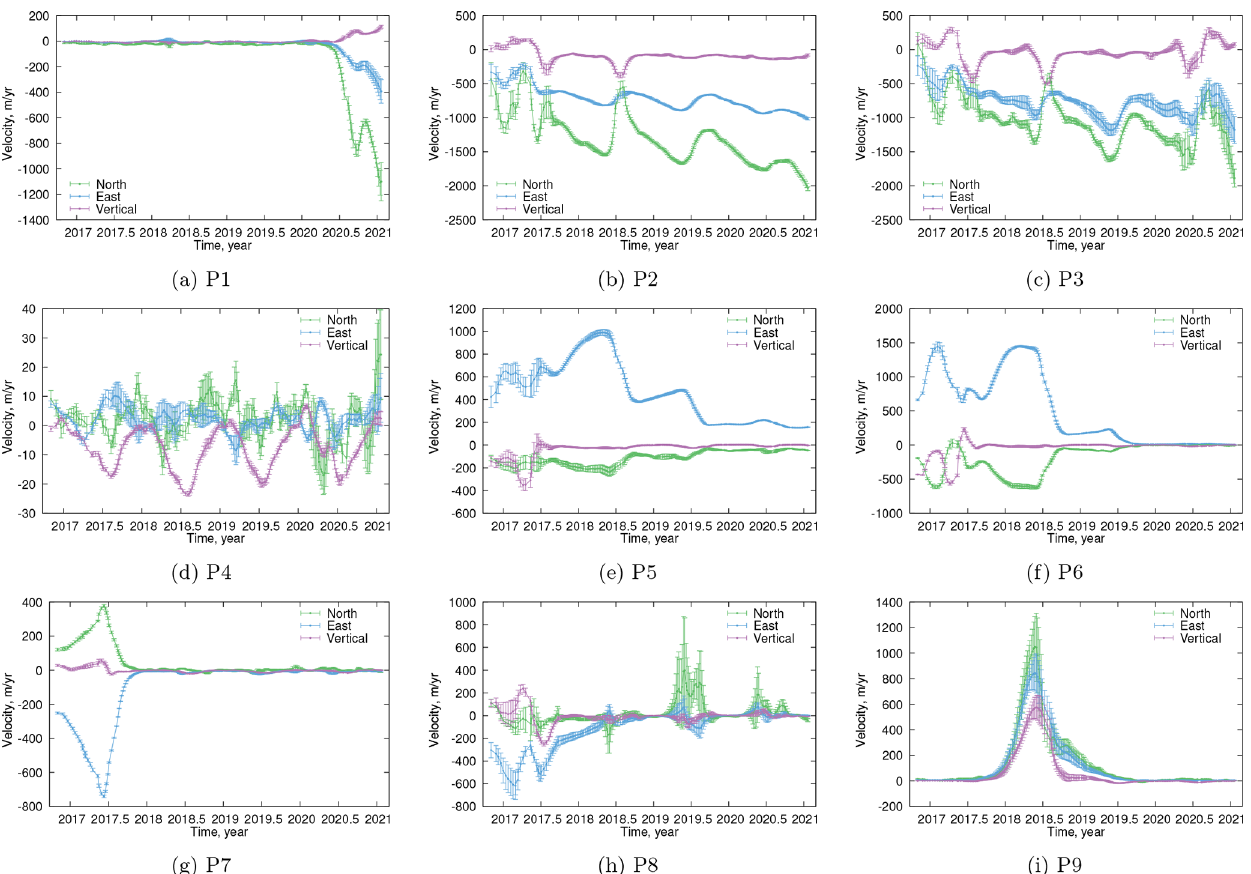
Figure 12. 3D flow velocity time series for regions P1–P9, the locations of which are shown in Figs. 6–10.